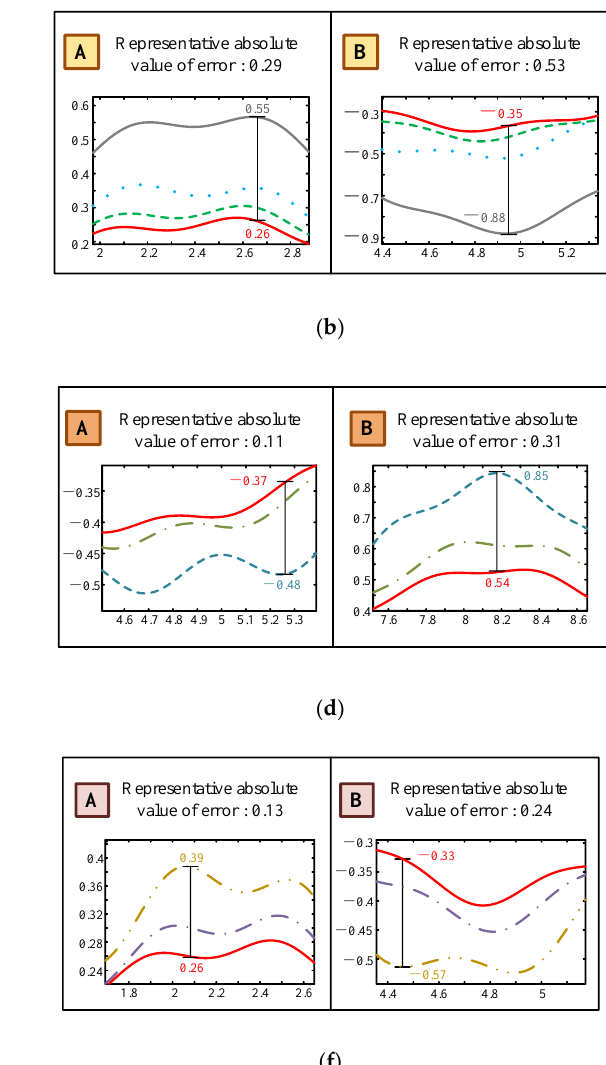
value of error : 0.13